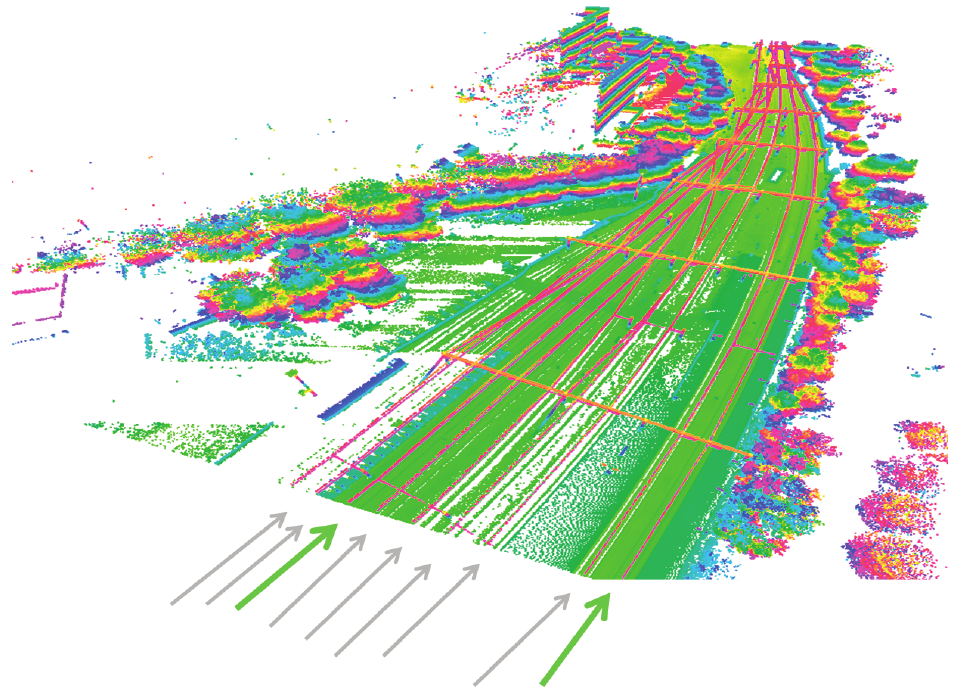
Figure 7. Point cloud from area near station Blerick ( top ) and Sittard ( bottom ). Data has been acquired on tracks indicated by the green